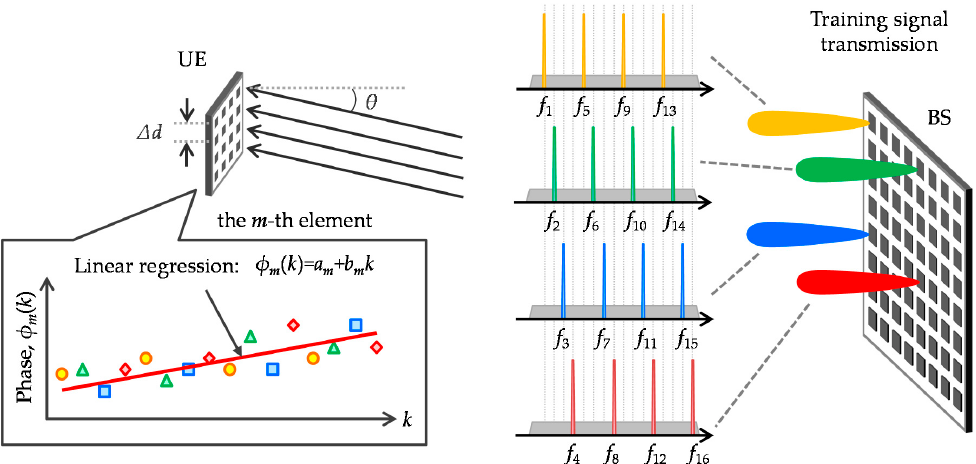
Figure 3. Proposed high efficient channel state information (CSI) estimation.